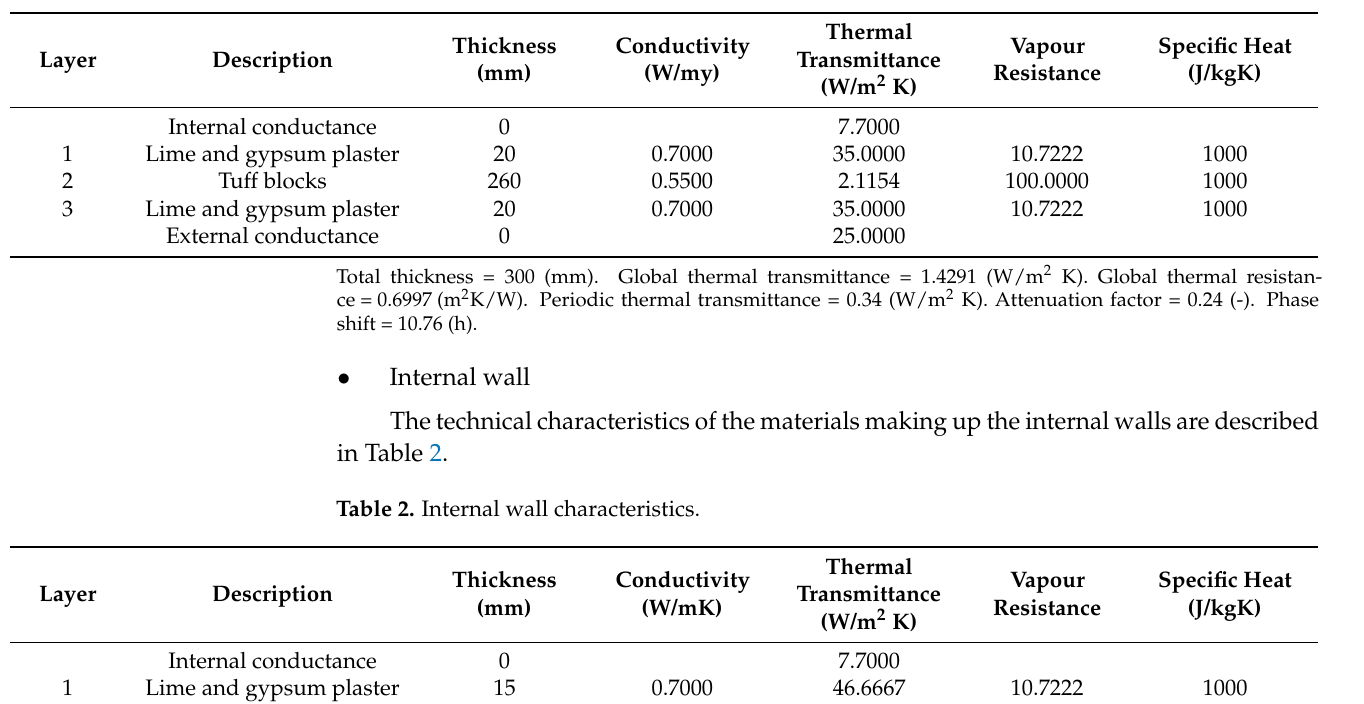
Table 1. External wall characteristics.